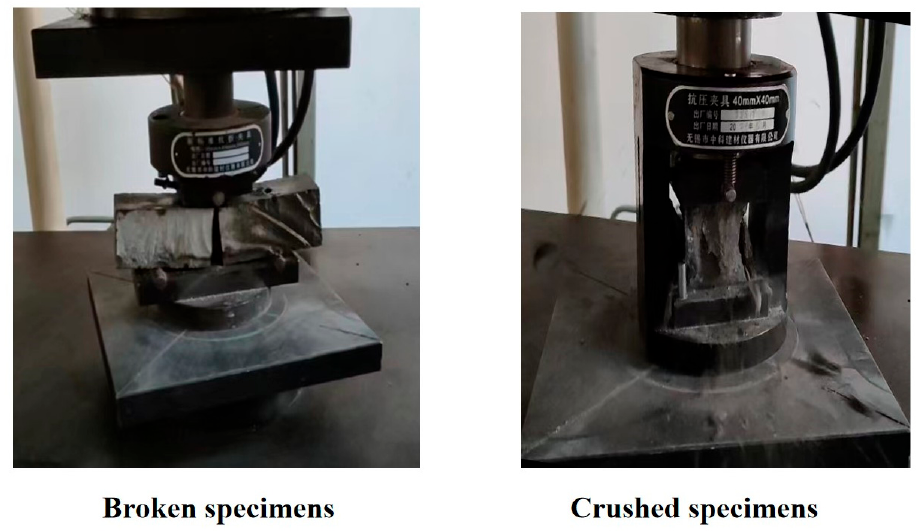
Figure 2. The measuring process of flexural and compressive